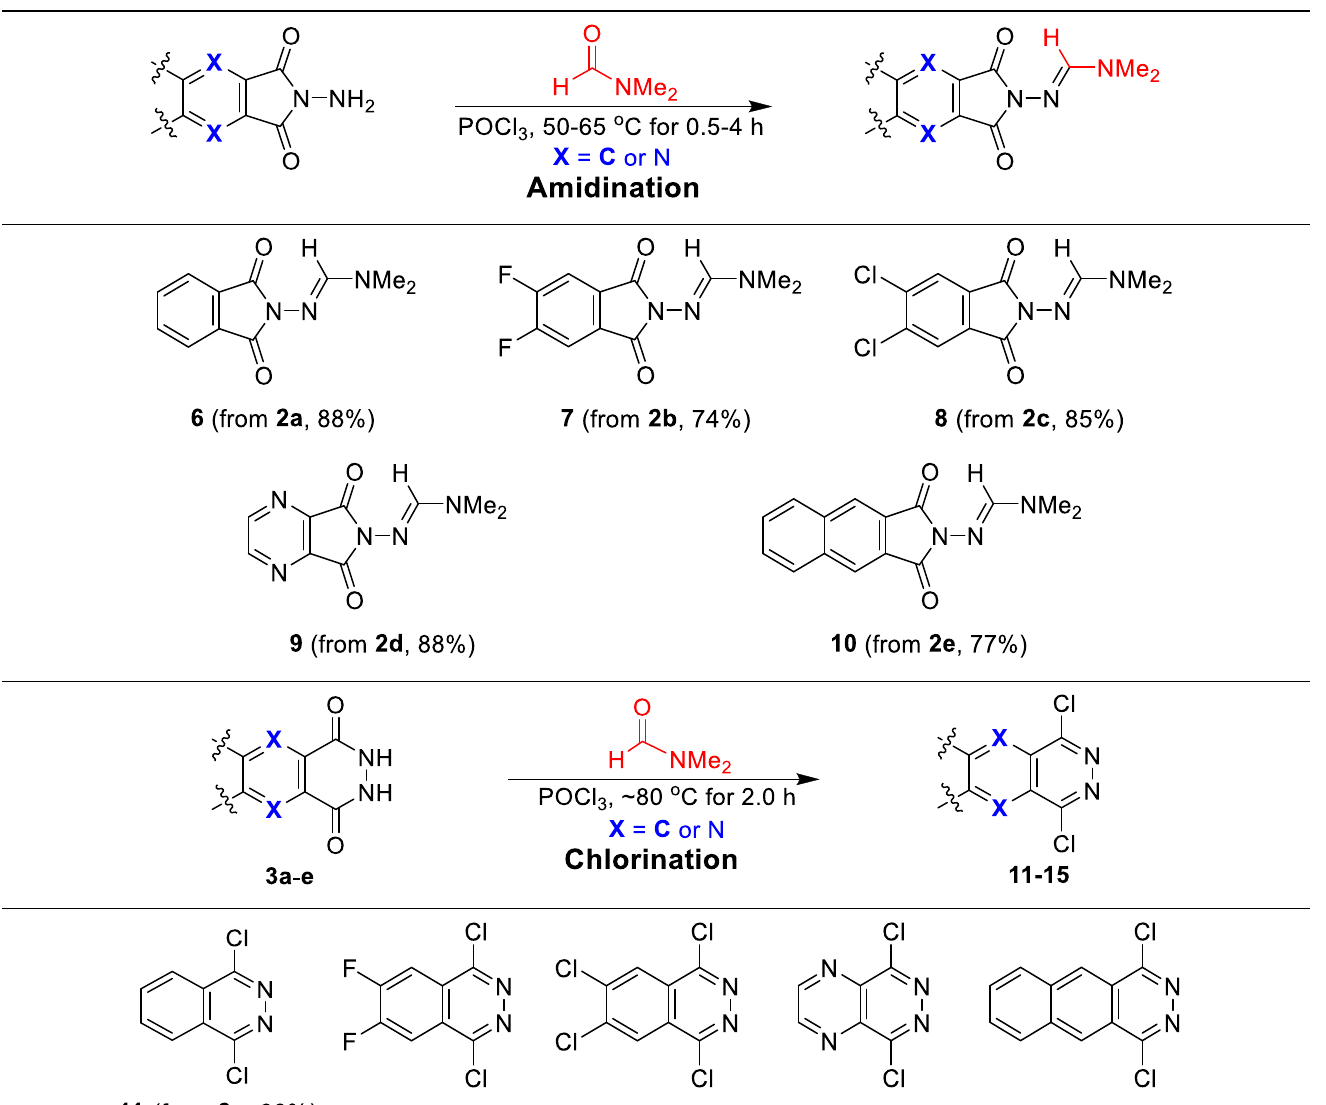
Molecules 2021 , 26 , x FOR PEER